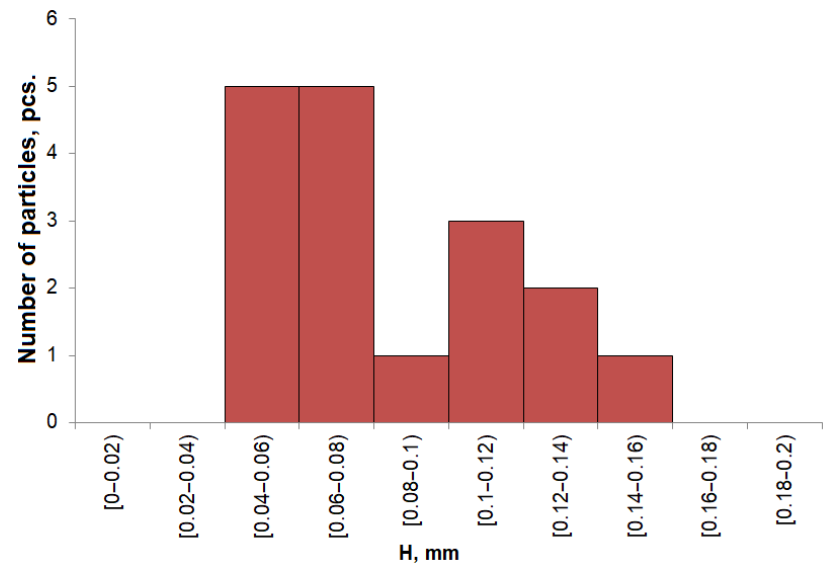
Figure 6. Example of a histogram of the Suspension particle size distribution at AMK-82 station No. 6939.